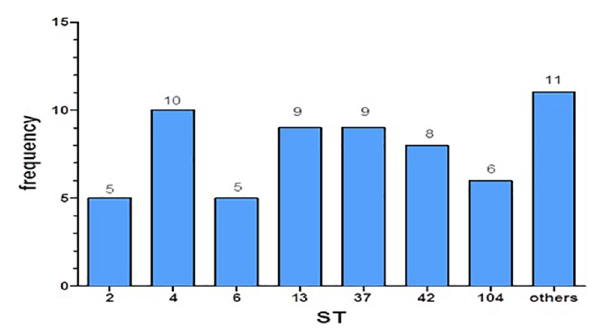
FIGURE 1 | Distribution of the different sequence types (STs) in the study.